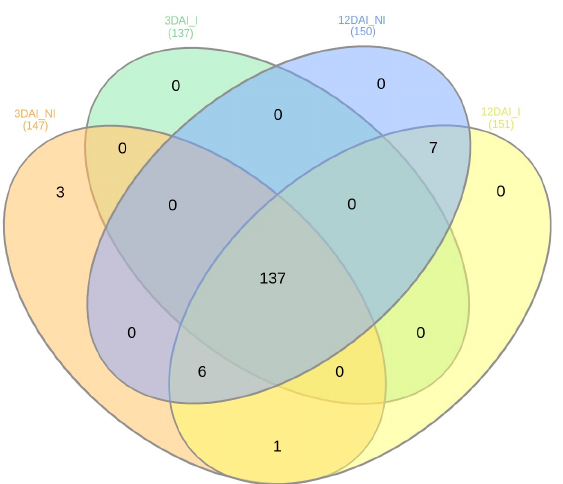
Figure 4. Numbers of abundant Musa acuminata var. Calcu tt a 4 miRNAs observed across the four small RNA libraries, each with an excess of 1000 read